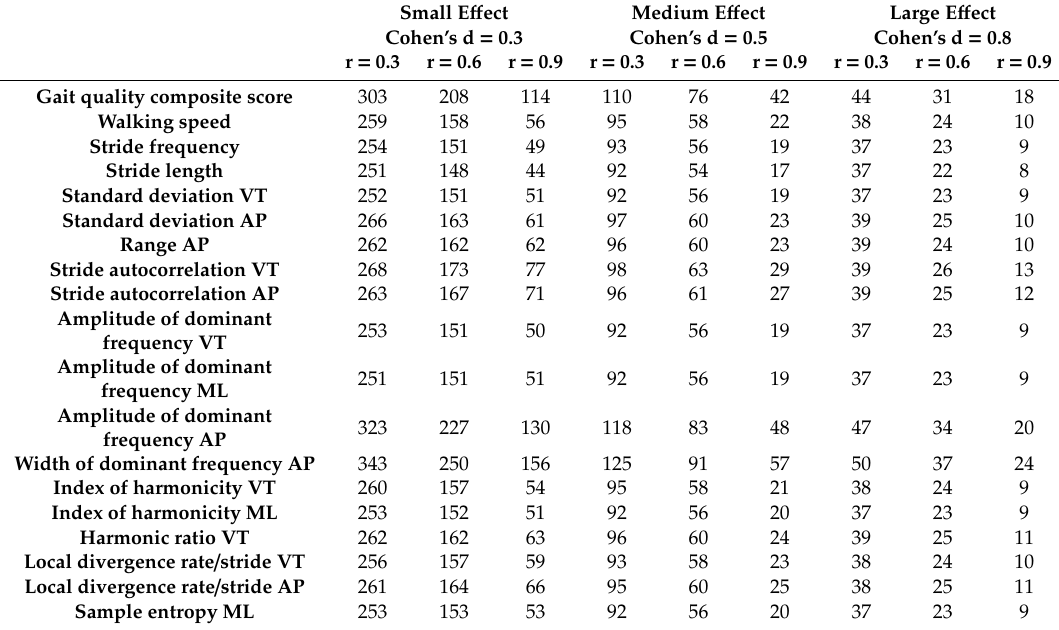
Figure 2. Number of participants required to detect an effect of Cohen’s d on the gait quality composite score. Table 2. Number of participants required to detect an effect of Cohen’s d on gait characteristics associated with prospective falls in [10].